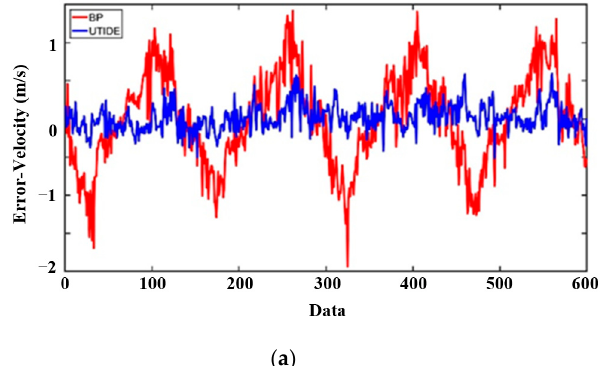
Figure 18. Enlarged figure of the comparison results in Figure 17.